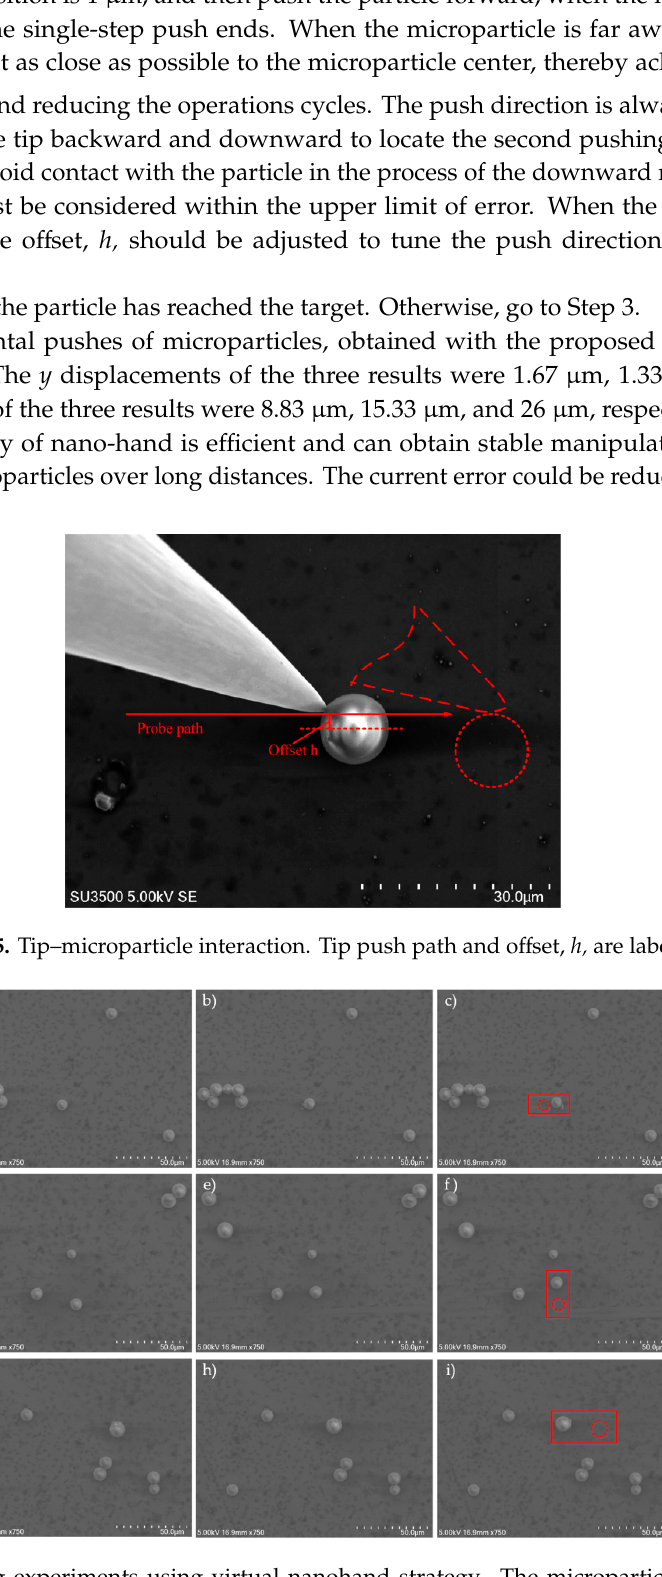
Figure 6. Pushing experiments using virtual nanohand strategy. The microparticle was pushed multiple steps from the beginning to its target. ( a , d , g ) Initial position. ( b , e , h ) Middle process. ( c , f , i ) Resultant position.